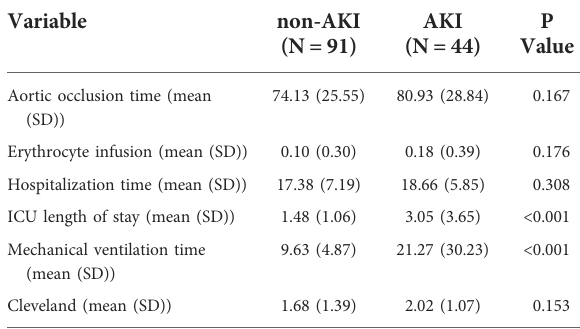
TABLE 1 Demographic and clinical characteristics of patients with or without AKI after cardiac